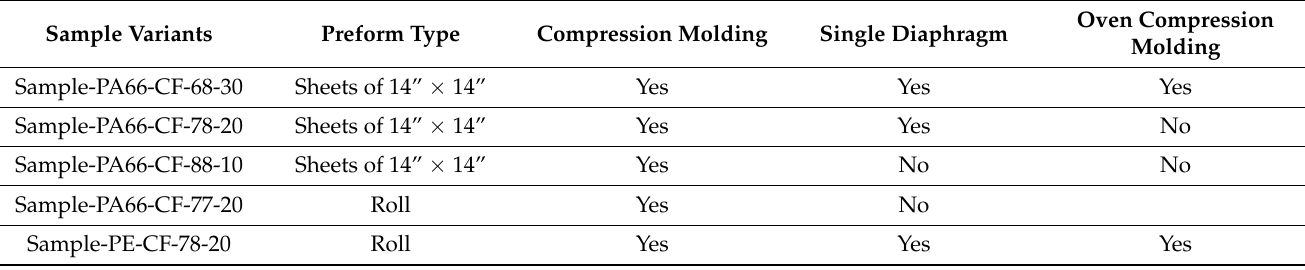
Table 15. Mats produced via different processing routes.